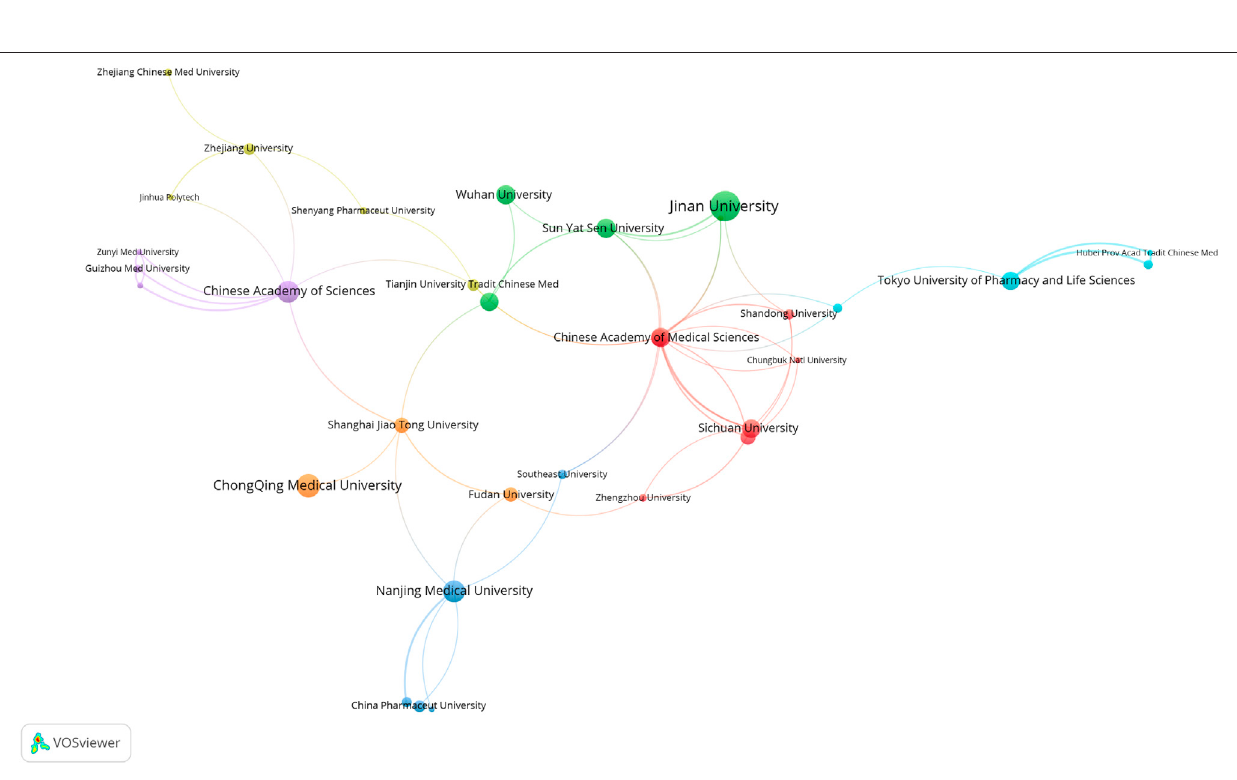
Frontiers in Pharmacology | www.frontiersin.org June 2022 | Volume 13 | Article 896050